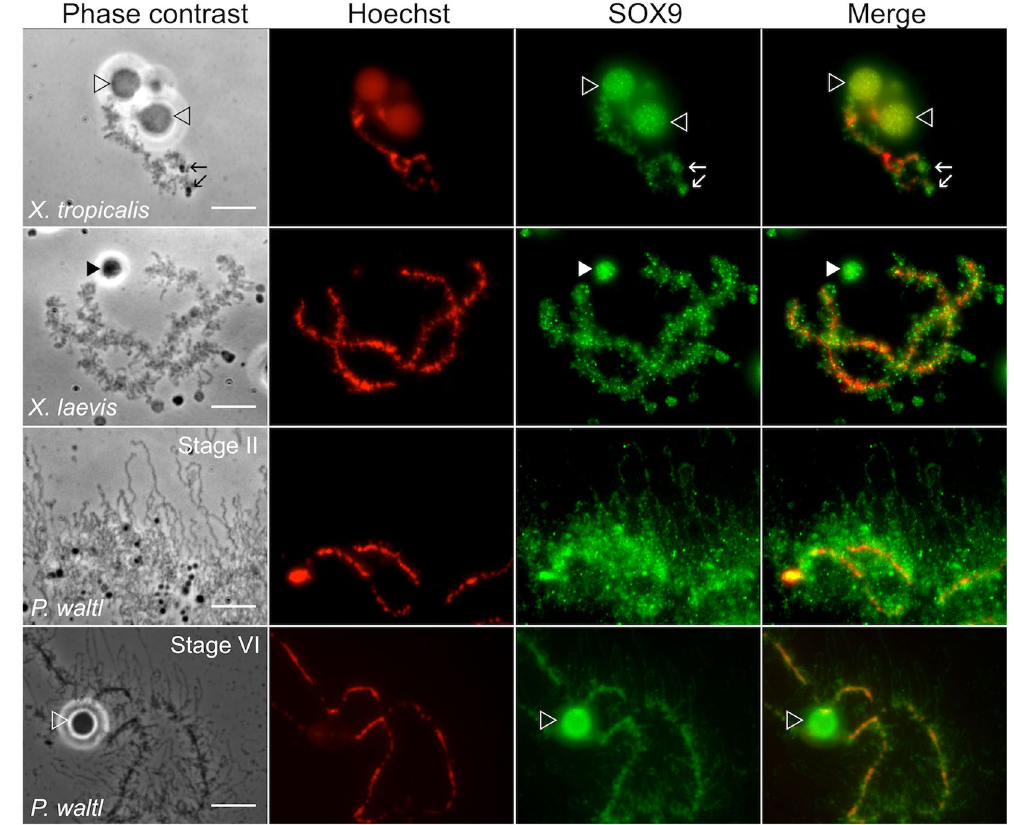
Figure 2. Subnuclear localization of the SOX9 protein in the GV of X. tropicalis , X. laevis and P. waltl . Fluorescent and corresponding phase contrast micrographs of nuclear spreads showing one LBC of X. tropicalis and X. laevis from stage V-VI oocyte, and part of a P. waltl LBC from stages II and V-VI oocyte. Nuclear spreads were immunostained with the anti-Cter-SOX9 antibody (green, Alexa 488 IgG) and counterstained with Hoechst (red). The Hoechst dye stained the chromosome DNA axis and not that of the decondensed lateral loops. The antibody labeled the LBCs, and the nuclear bodies either attached to them (empty arrowheads) or free in the nucleoplasm (full arrowheads). Note that the immunostaining of lateral loops was very clear in P. waltl LBCs from stage II oocyte, because of their extension and density. The intensity of fluorescence in the different experiments was normalized with respect to their relevant controls with the secondary antibody (tagged with Alexa fluor 488) alone. Wide field Leica microscope. Scale bar for all micrographs: 10 μ